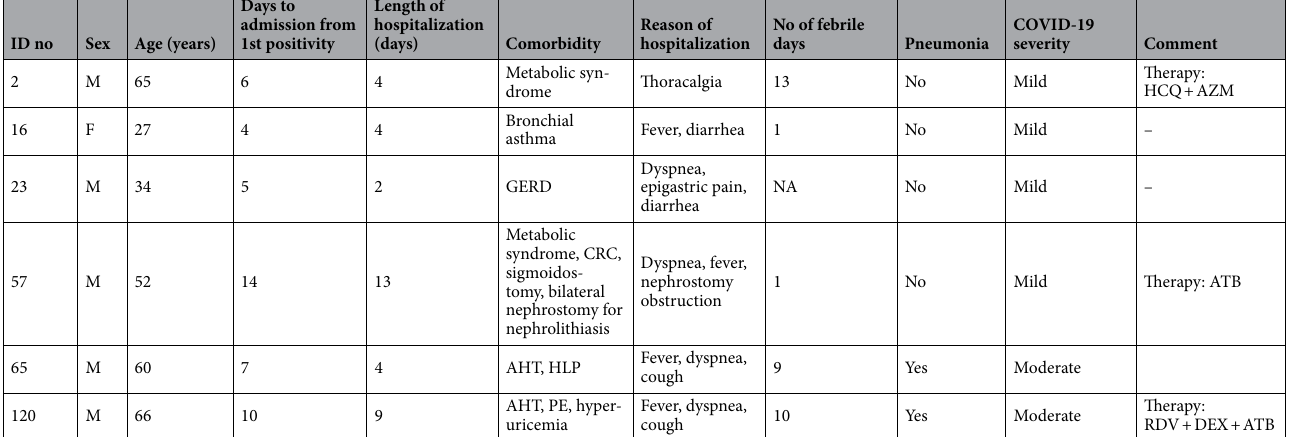
Association between symptoms and comorbidities. We analyzed the relationship between patients’ characteris- tics and comorbidities with the number of symptoms. In general, a linear relationship appeared between a higher number of comorbidities and a higher number of symptoms (p = 0.209) (Fig. 5). However, neither an older age (p = 0.077), female gender (p = 0.254), diabetes mellitus (p = 0.129), cancer (p = 0.699), nor allergies (p = 0.171) were determined statistically significantly correlated with the number of disease symptoms. Patients exhibiting fewer symptoms were those with a higher BMI (p = 0.370) and, surprisingly, smokers (p = 0.096), although this relationship was statistically insignificant. Hypertension did not affect the symptom number (p = 0.548), but